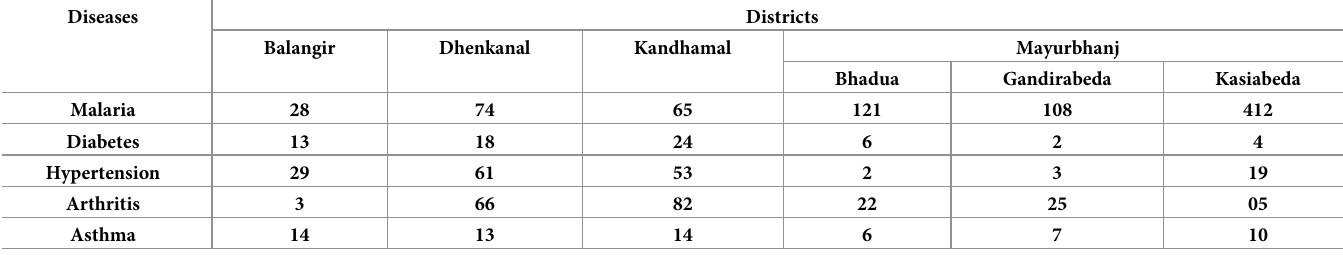
Table 3. Depicts some common diseases prevalent in the study